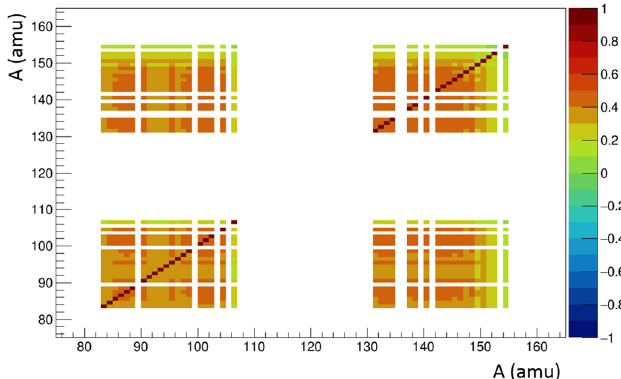
Fig. 2. Correlation of Maeck set after renormalization to Diiorio set as a function of mass